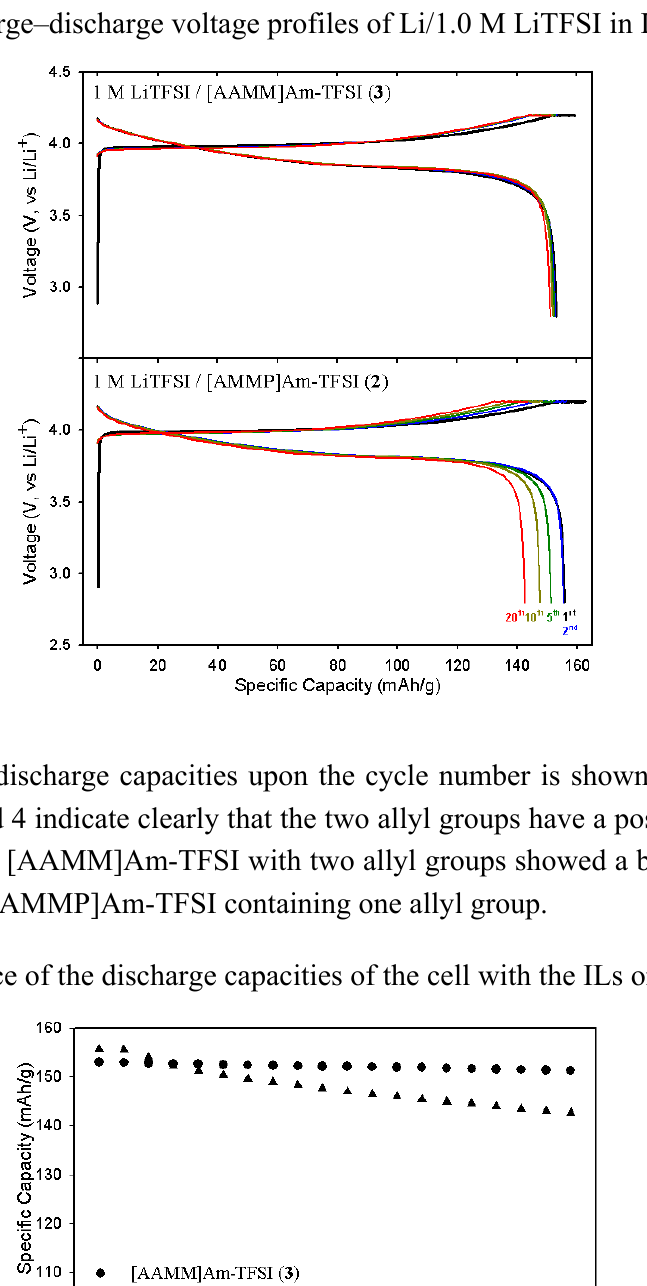
Figure 3. The charge–discharge voltage profiles of Li/1.0 M LiTFSI in ILs/LiCoO